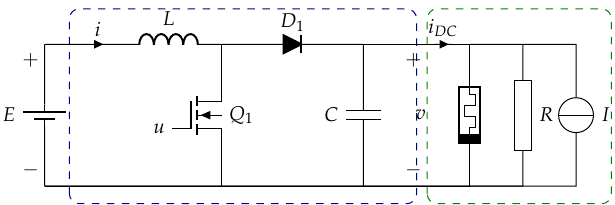
Figure 2. Scheme of a DC-DC boost converter supplying a